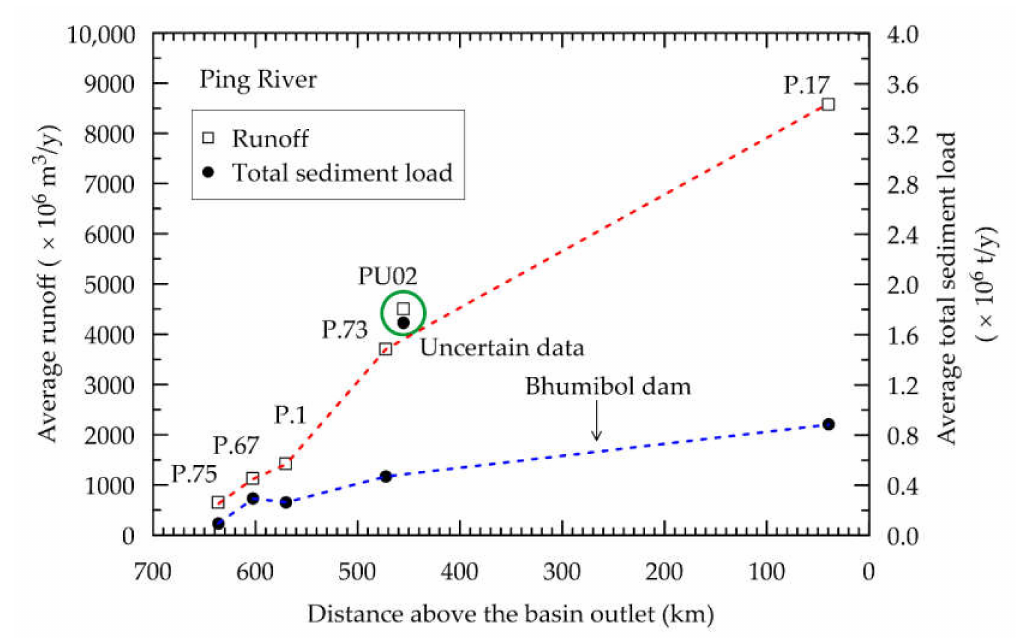
Figure 6. Plots of average annual river runoff and annual total sediment load along the Ping River and C.2 between 1999 and